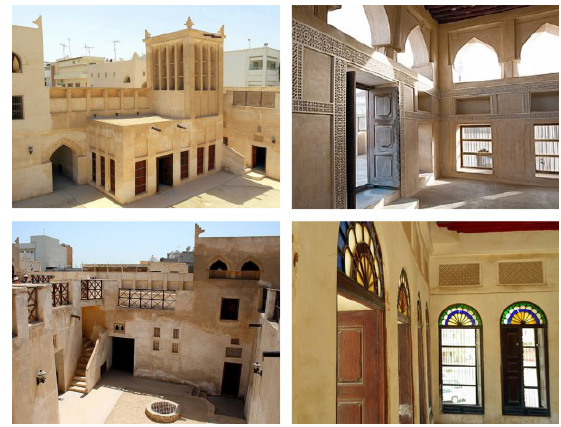
Figure 1. The house of Shaykh Isa bin Ali Al-Khalifa and its unique architectural elements.